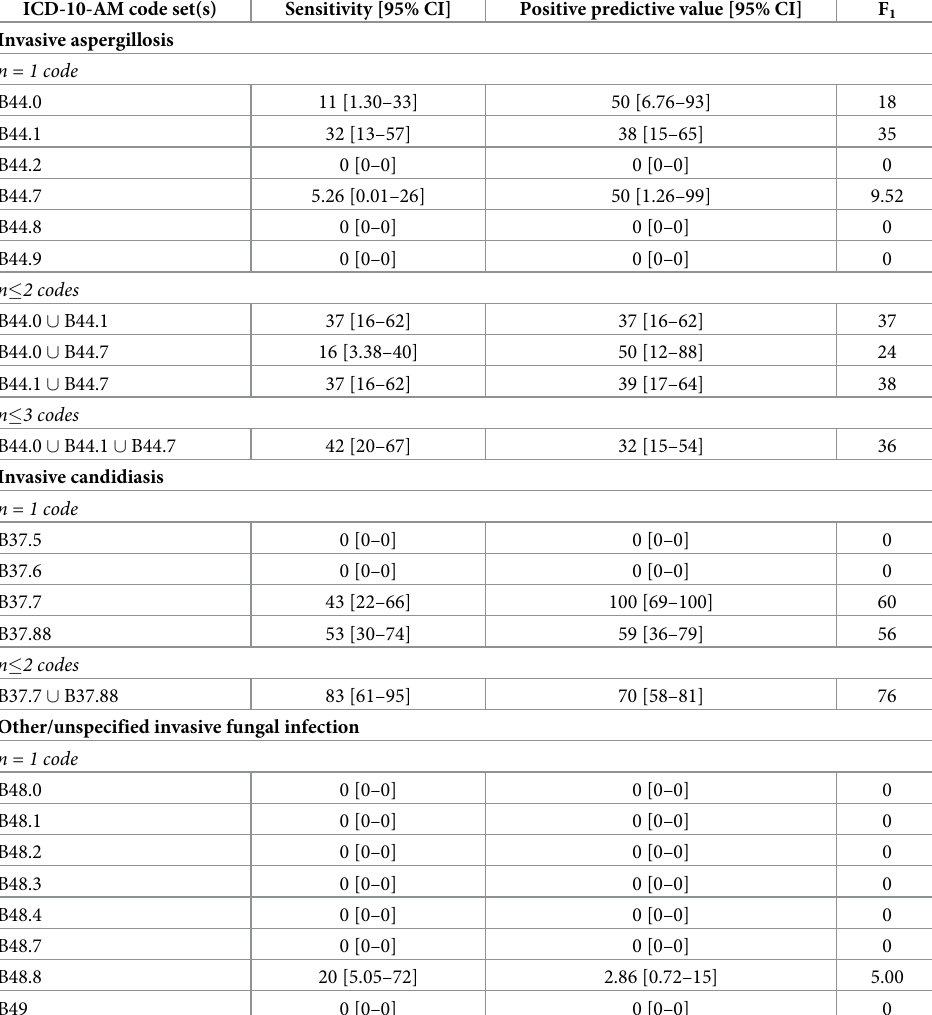
Table 4. Performance (in percent) of different coding abstractions stratified by invasive fungal infection in the study cohort, N = 1,671. ICD-10-AM code set(s)